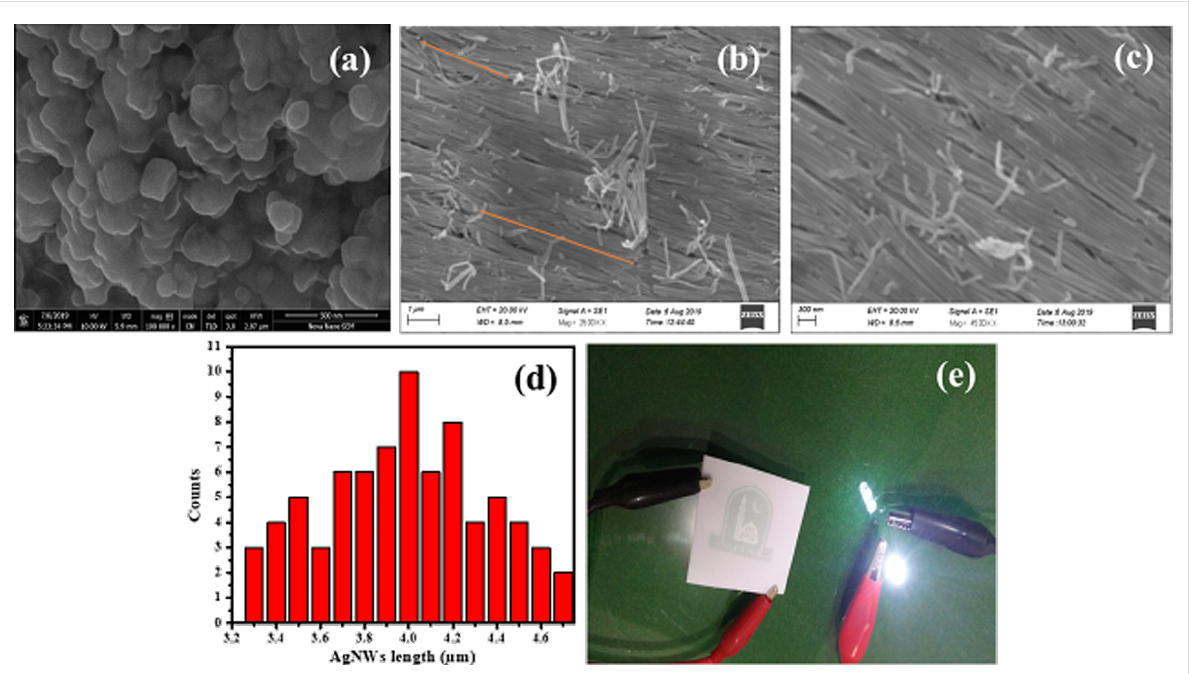
Figure 4: SEM images of (a) AgNPs collected just after complete addition of AgNO 3 to the reaction solution and (b, c) AgNWs in high yield exhibiting parallel alignment over large regions (collected after 60 min of reaction). (d) Histogram showing the distribution of AgNWs length in the prepared sam- ple. (e) An electric circuit with a lit white LED showing the conductivity of a AgNW-loaded PET film (with sandwiched logo of the institution). The circuit was placed on a glass table with green background.